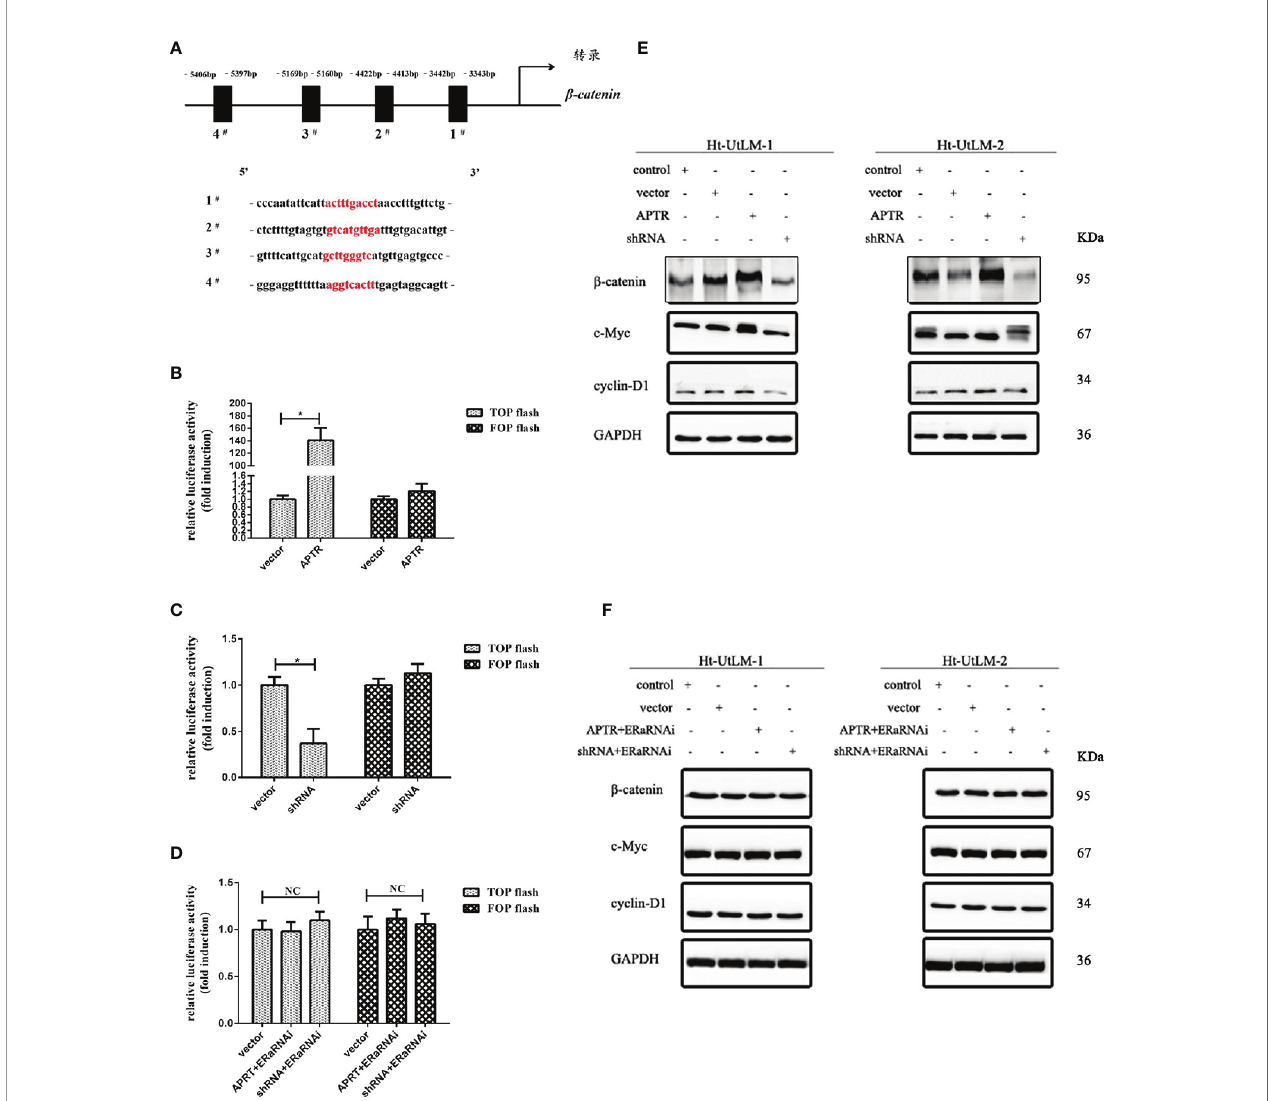
FIGURE 4 | APTR activated the canonical Wnt pathway in Ht-UtLM cells by targeting ER a . (A) b -Catenin promoter has four ER a binding sites. (B) Cells were infected with or without APTR together with the TCF-luciferase reporter (TOP fl ash) or mutant TCF-luciferase reporter (FOP fl ash) for 24 h. Upregulated APTR increased TOP fl ash activation in Ht-UtLM cells. (C) Downregulated APTR repressed TOP fl ash activation in Ht-UtLM cells. (D) Infection with APTR and ER a RNAi did not affect the basal TOP fl ash activity. (E, F) Ht-UtLM cells were infected with APTR or shRNA alone or together with the ER a RNAi. Western blot analysis was performed with GAPDH as the loading control. (* P < 0.05, ** P <